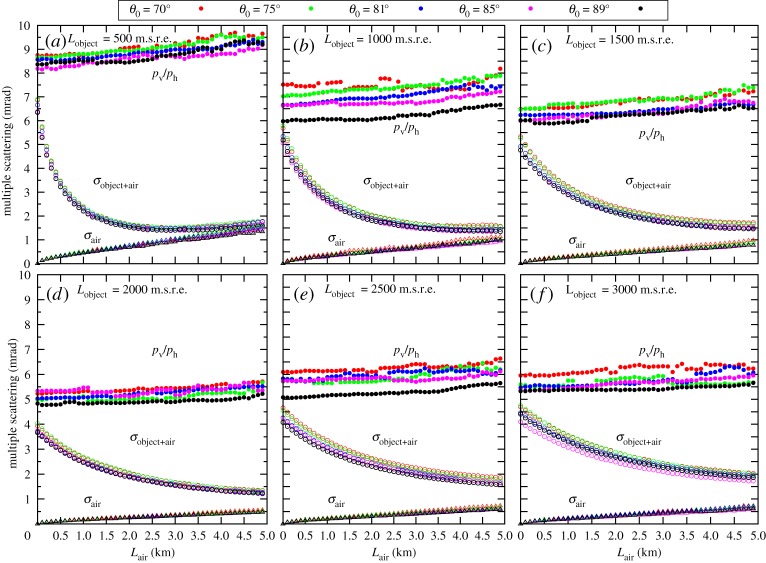
The multiple scattering of muons across large-scale objects. The ratio of horizontal component to vertical component of momentum direction vector (pv/ph), the multiple scattering before the MOS (σobject+air) and across the air (σair) are plotted as the function of object-MOS distance for 500 m.s.r.e. (a), 1000 m.s.r.e. (b), 1500 m.s.r.e. (c), 2000 m.s.r.e. (d), 2500 m.s.r.e. (e) and 3000 m.s.r.e. (f), respectively.